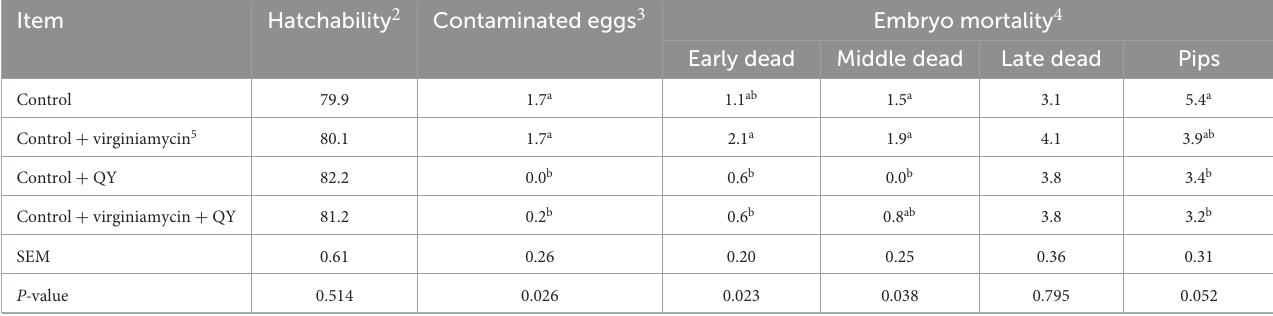
TABLE 6 Incubation parameters (%) of laying breeders hens fed diets supplemented with an additive from Quillaja saponaria and Yucca schidigera (QY) 1